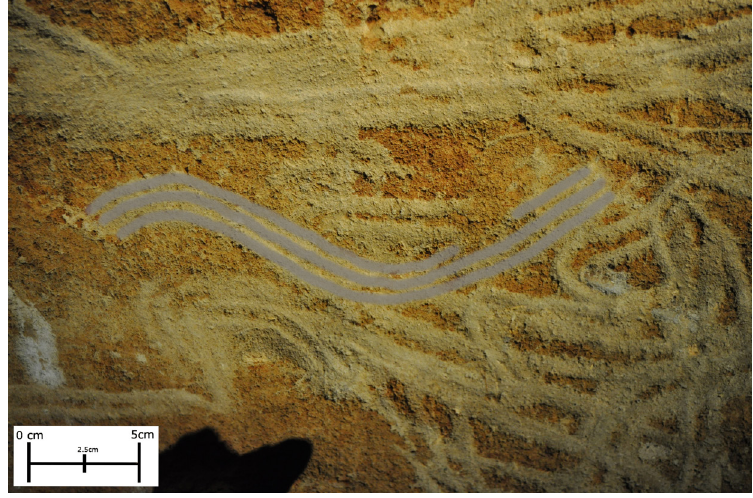
Figure 11. Fluting by young child (22mm) in Rouffignac, likely with the guidance of an adult. The resolution of the dating of flutings is also not clear, and to fully support or disprove this interpretation clear dates are needed. Evidence from Rouffignac, Gargas, and Las Chimeneas suggests that some of the fluters were part of the same community of practice based on the stratigraphy of the flutings. However it